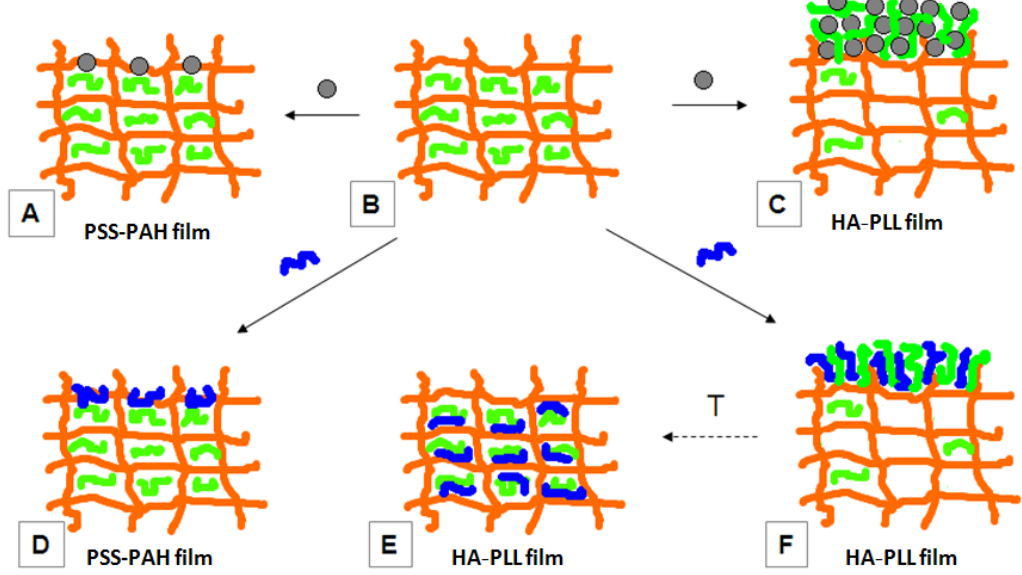
Figure 4. A scheme representing the interaction of the LbL film ( B ) made of HA (orange network) and PLL (in green) with metal nanoparticles (grey spheres, B → A and B → C ) and DNA (in blue, B → D and B → F ). DNA or the nanoparticles can be accumulated in high amount because of interaction with PLL molecules “transported” from the film interior to the surface. DNA diffusion into the HA/PLL film is induced by heating (70 °C, F → E ). (Adapted with permission from [25]. Copyright 2009 American Chemical